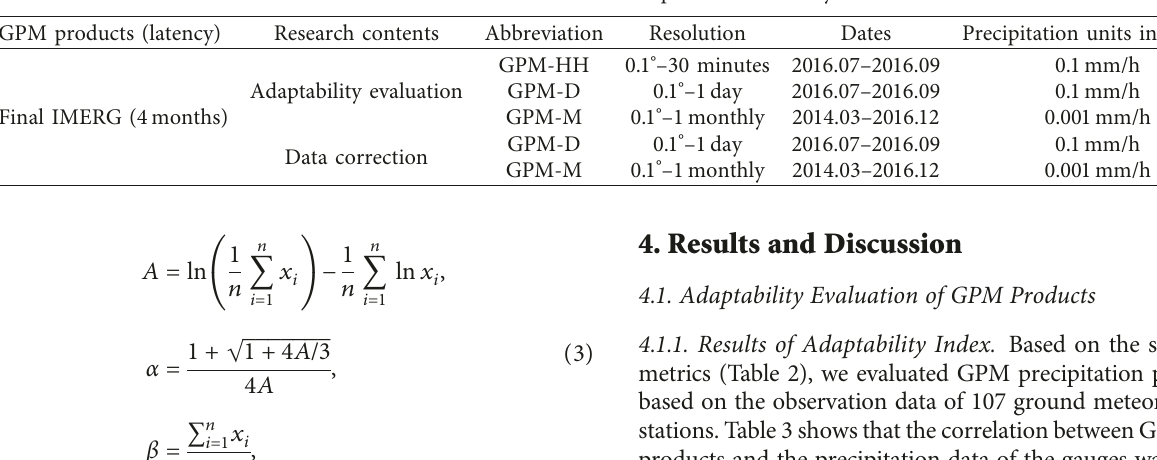
Table 1: GPM final IMERG products